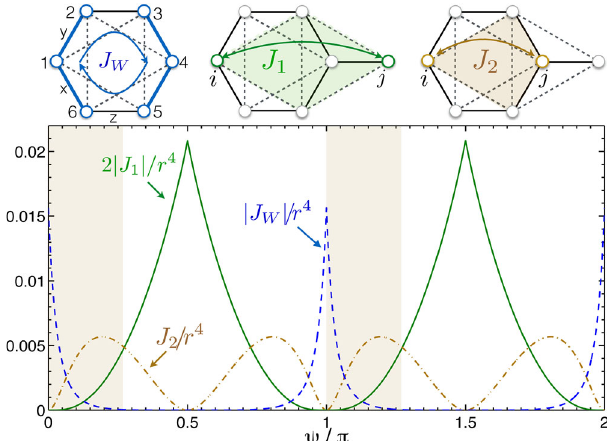
j =r 4 , 2 j J j =r 4 , and 1 W